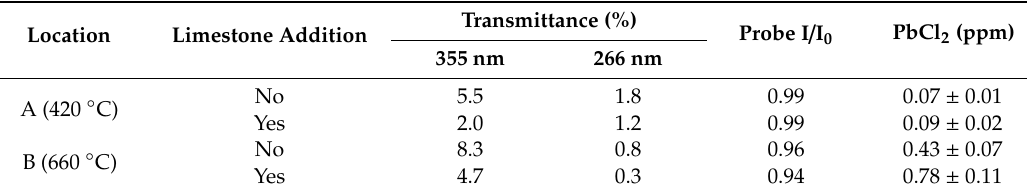
Table 1. Measurement parameters and main results from PbCl 2 detection through a 10-m-wide flue gas passage using the CPFAAS